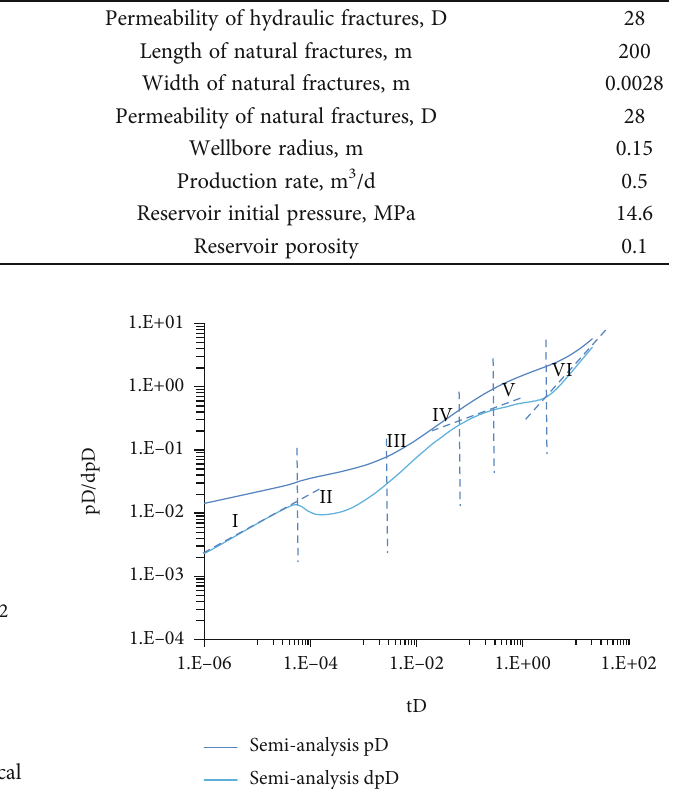
Table 1: Data used for semianalytical and numerical models.